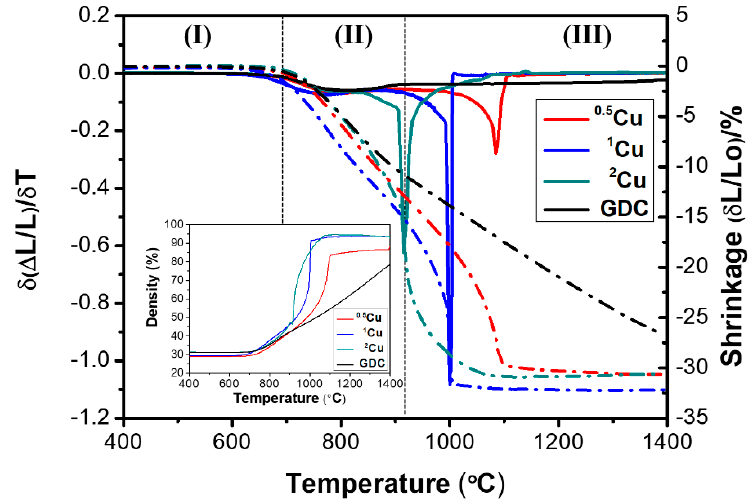
Figure 3. Shrinkage rate (solid) and linear shrinkage (dotted) as a function of temperature for GDC and Cu co-doped samples and densification curves as a function of temperature (inset).